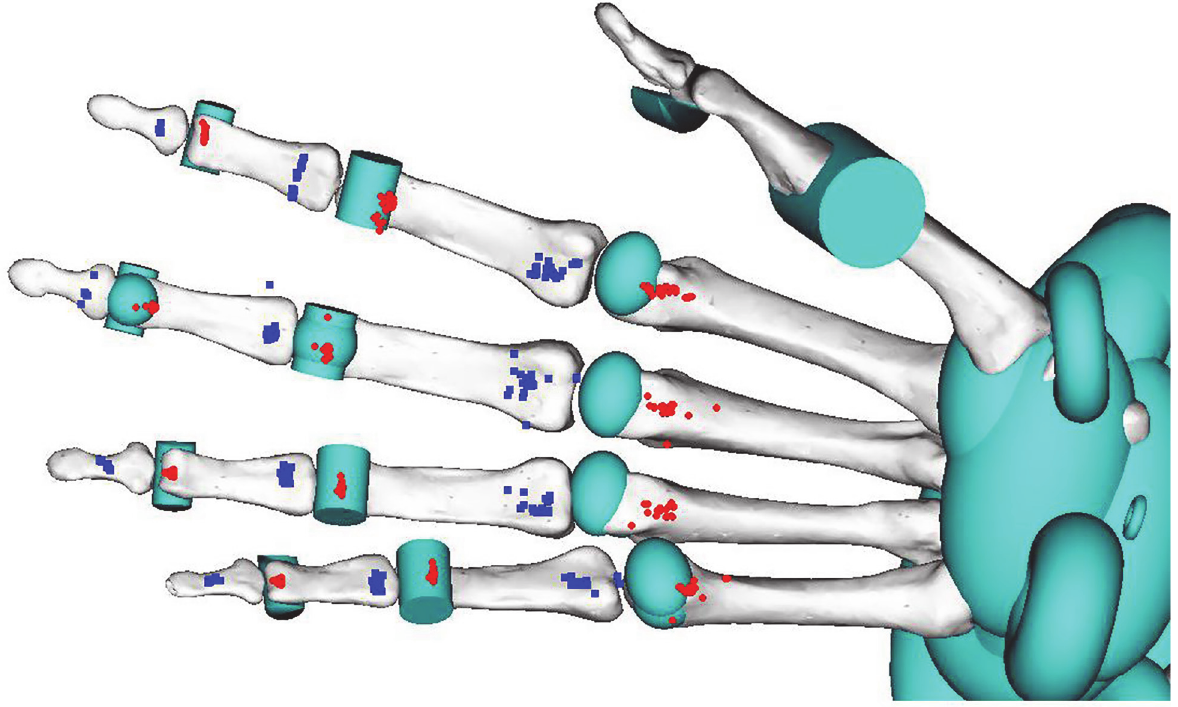
Fig 5. Muscle attachment points for modeled FDP muscles at the MCP, PIP and DIP joints. Red circles and blue squares denote proximal and distal points,